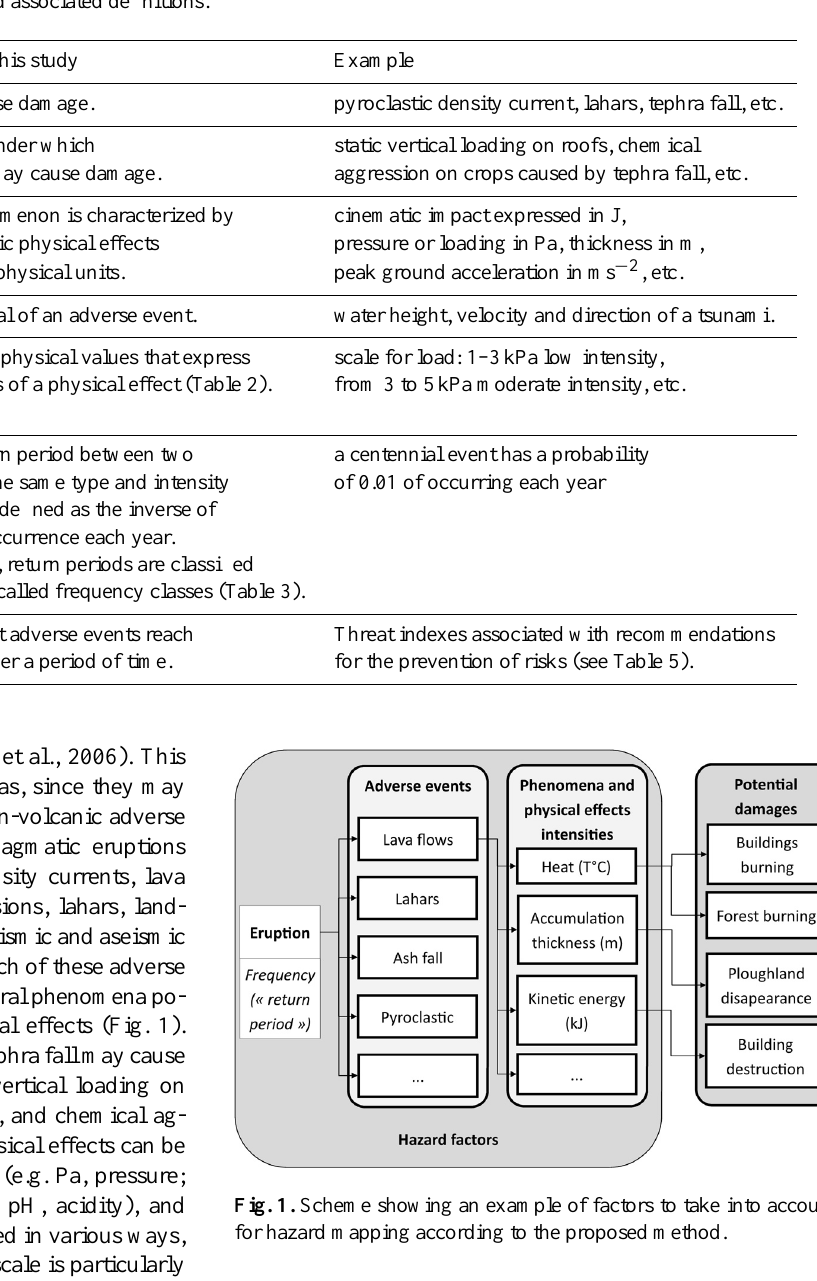
Table 1. Key vocabulary used in this paper and associated definitions.